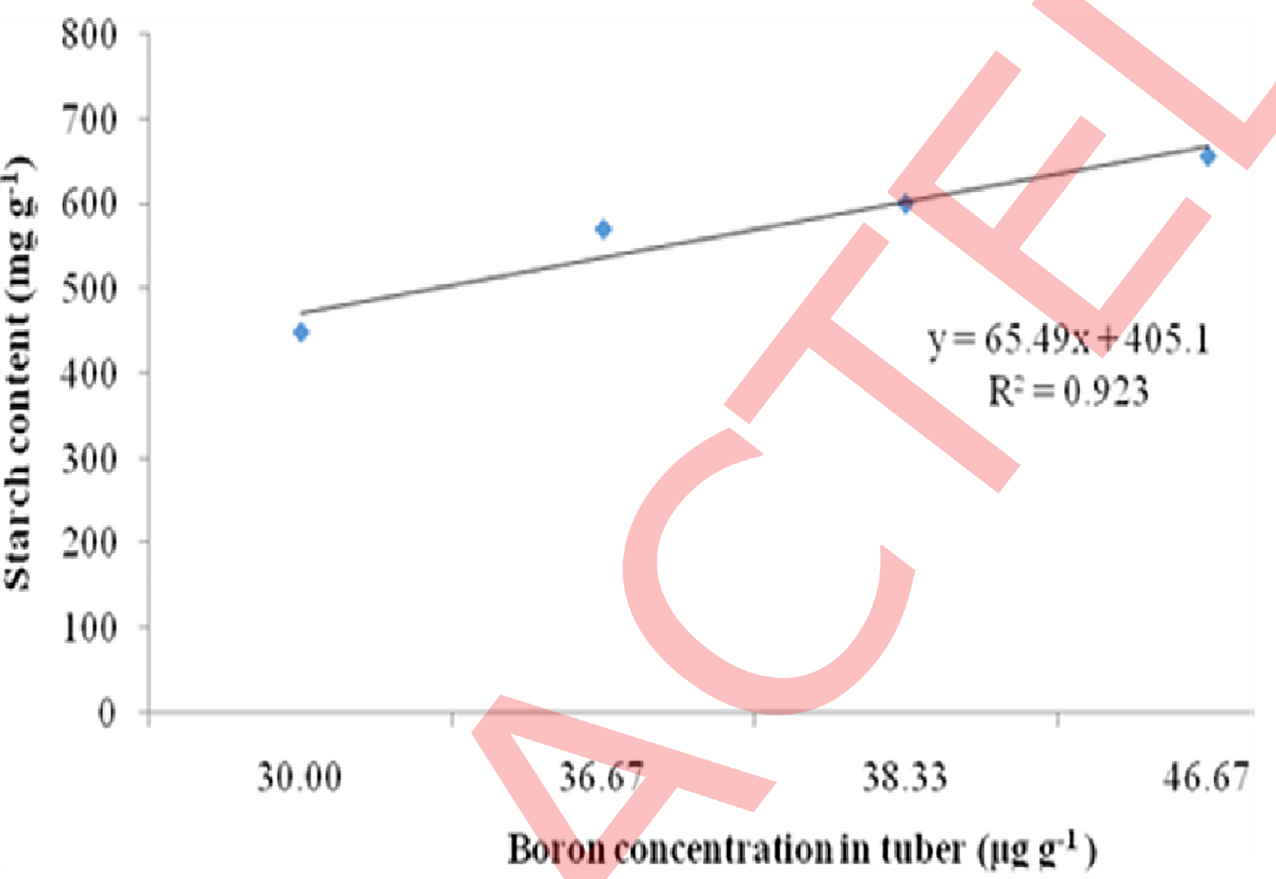
Fig 4. Relationship of starch concentration (mg g -1 ) and B concentration in potato tuber.